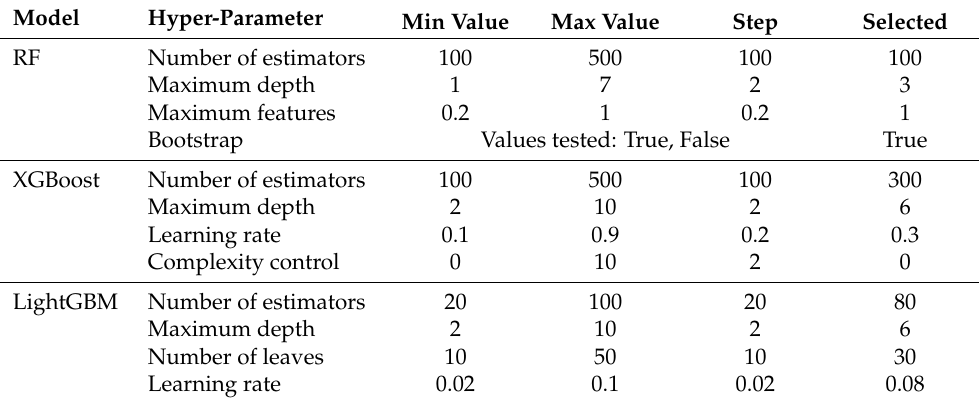
Table 2. The search space and the selected values of the hyper-parameters for the tree-based regression models considered for predicting energy